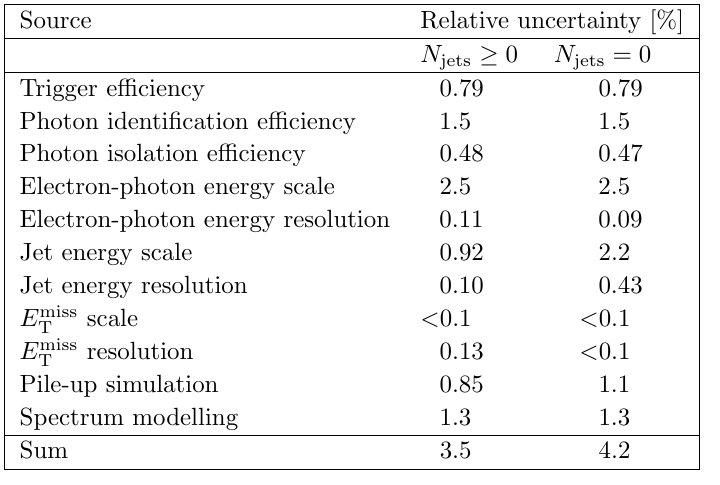
Table 5 . Relative systematic uncertainties in the signal correction factor C Z(cid:13) for the inclusive and exclusive Z(cid:13)